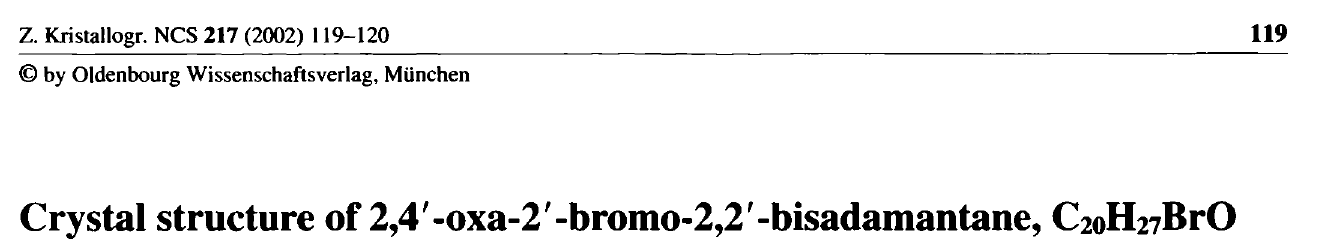
Table 1. Data collection and handling.